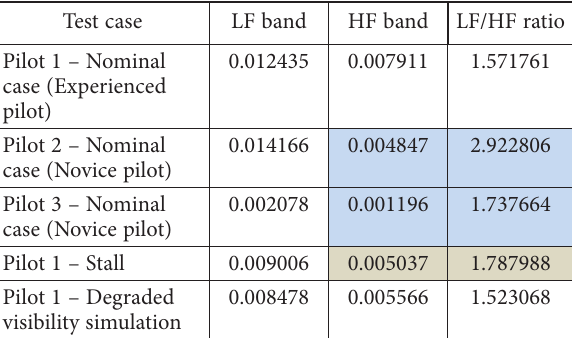
Table 1. Mean PSD values for different frequency bands